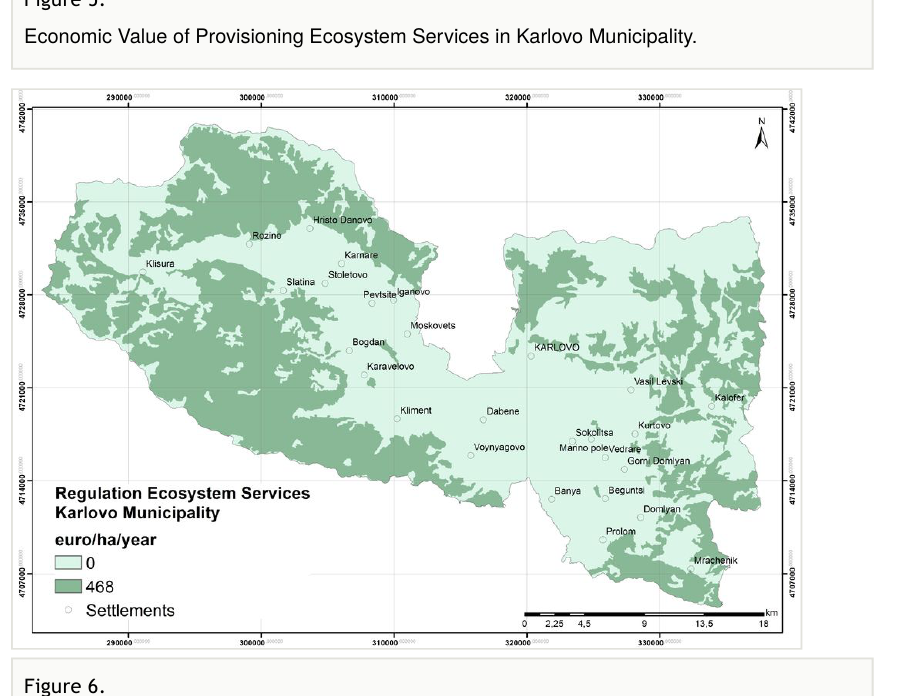
Figure 6. Economic Value of Regulation Ecosystem Services in Karlovo